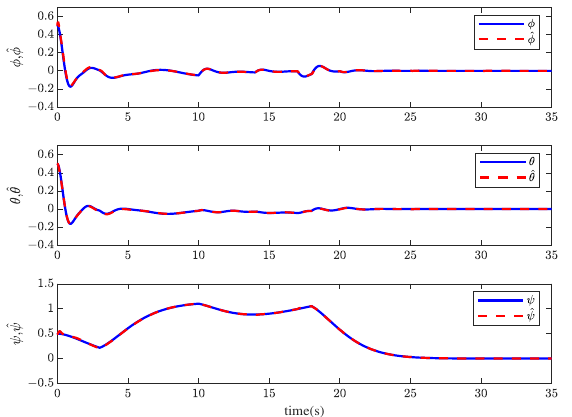
Figure 9. The actuator fault, sensor fault, and disturbance estimation errors e f ( t ) when z = 1 s. e d s